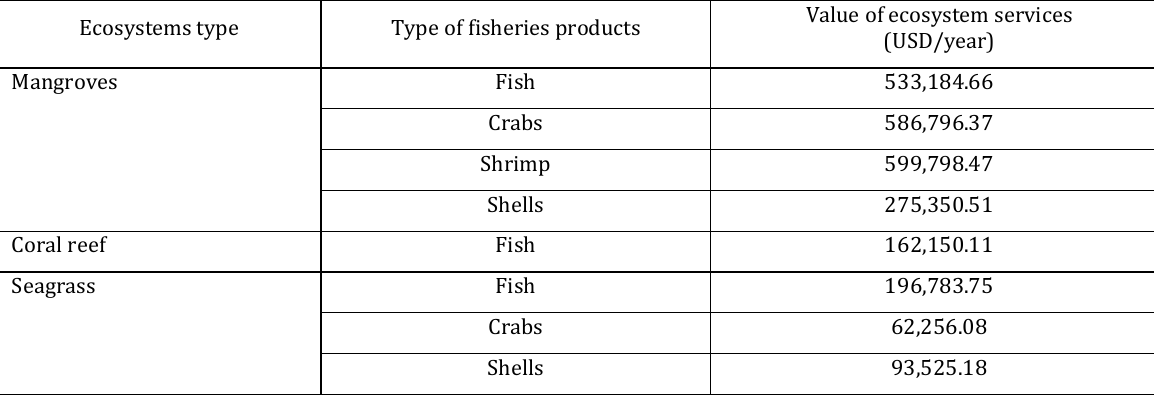
Table 2. The value of CES as the provision of fishery products in the coastal area of Jayapura City, Papua Province, Indonesia Ecosystems